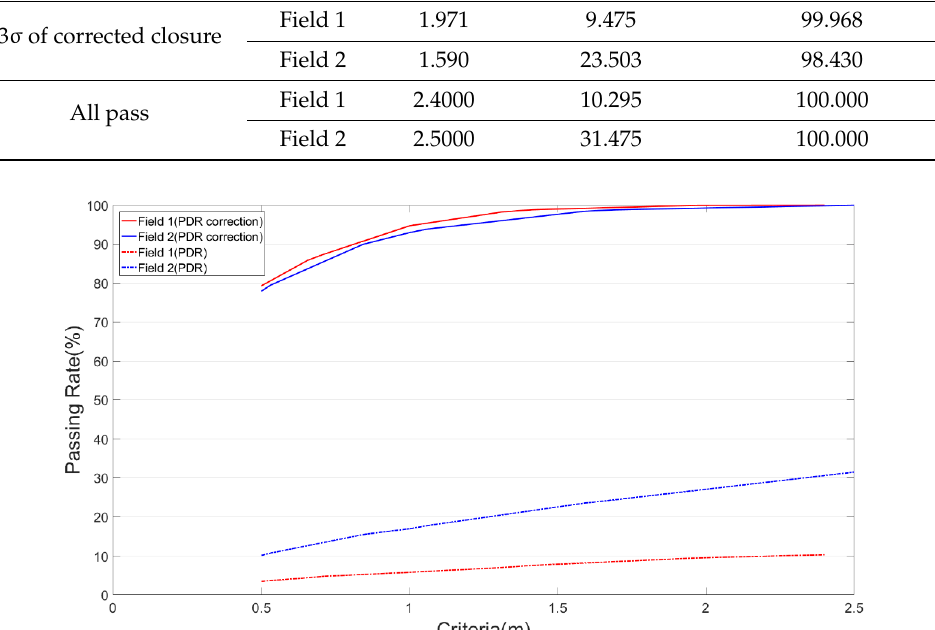
Figure 15. Criteria of vertical offsets.